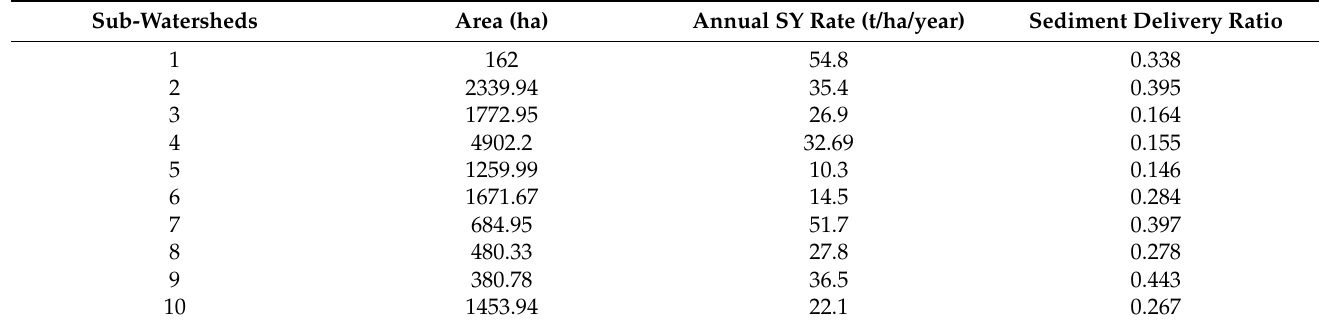
Table 6. Summary of the offsite GeoWEPP model simulation for ten selected